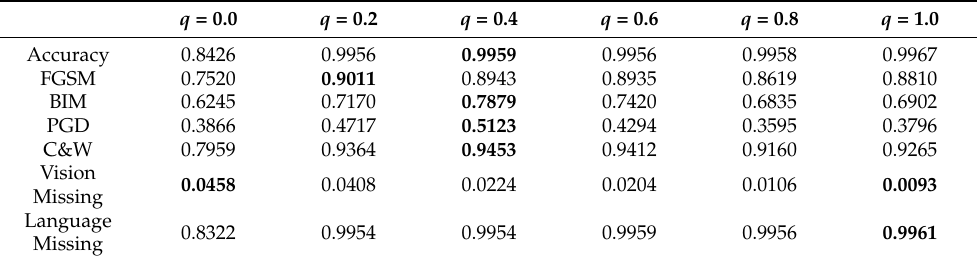
Table 9. Accuracy averages for different cases with different values of visual modal integrity proba- bility parameter q for the Flowers dataset.